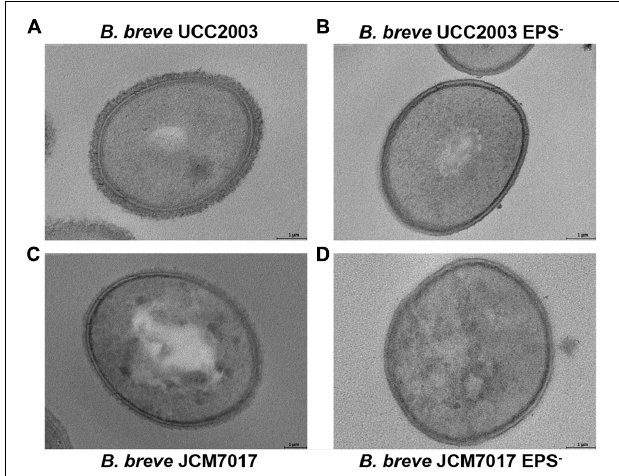
FIGURE 3 | Confirmation of EPS production by B. breve UCC2003, JCM7017 and EPS − mutants. Transmission electron microscopy images of B. breve UCC2003 (A) , B. breve UCC2003 EPS − (B) , B. breve JCM7017 (C) , and B. breve JCM7017 EPS − (D)